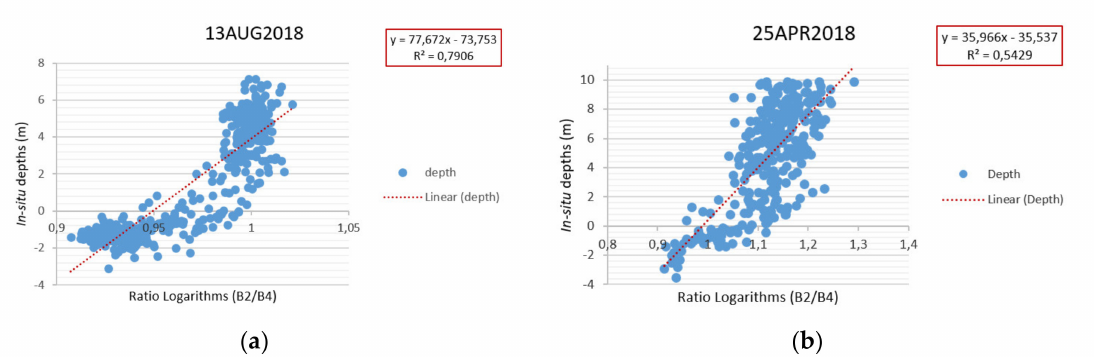
Figure A1. Linear regression graphics between in situ measurements (depths in meters) and the logarithm ratio. ( a ) Tagus estuary—13AUG18 S2A L2A image. ( b ) Bijag ó s archipelago—25APR18 S2B L2A image. (Red dashed line: linear regression best fit; red rectangle: correlation coe ffi cient (R 2 ) between data sets and Equation (7) solution).